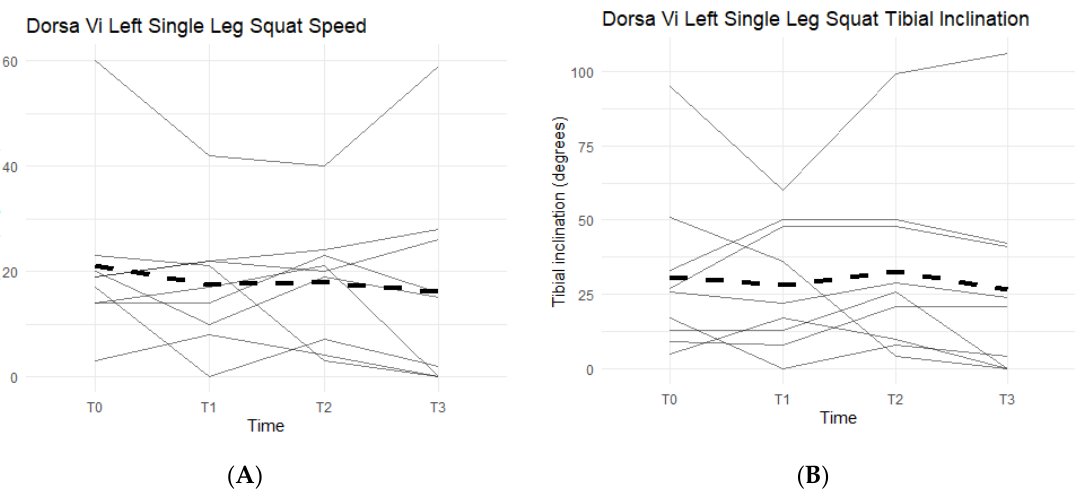
Figure 14. Left Single-Leg Squat Changes Over Time. Changes in single-leg squat speed and tibial inclination were graphed to compare results at T0, T1, T2, and T3. ( A ) graphs speed measured in degrees per second as a function of time. ( B ) graphs tibial inclination in degrees as a function of time. Solid lines represent individual data, dashed lines are group averages.